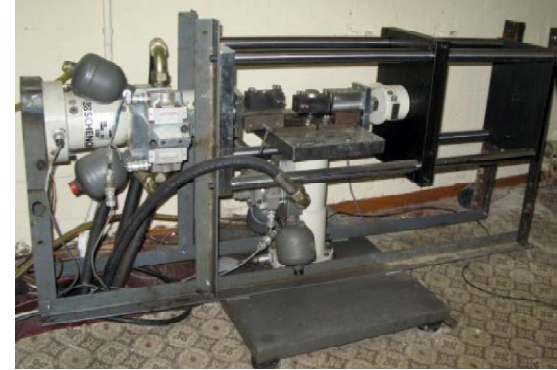
Fig. 2. Linear friction welding laboratory